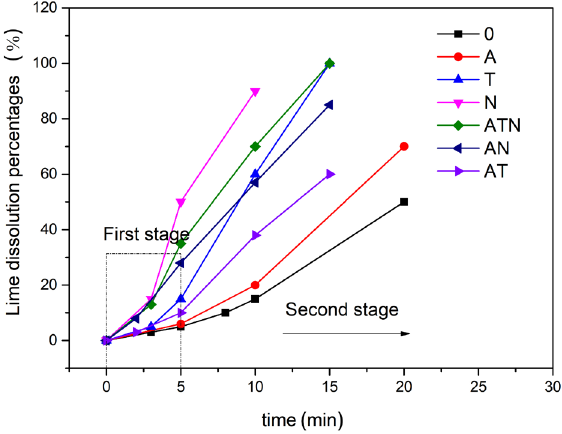
Figure 4. Dissolution percentages of lime in different slag samples.